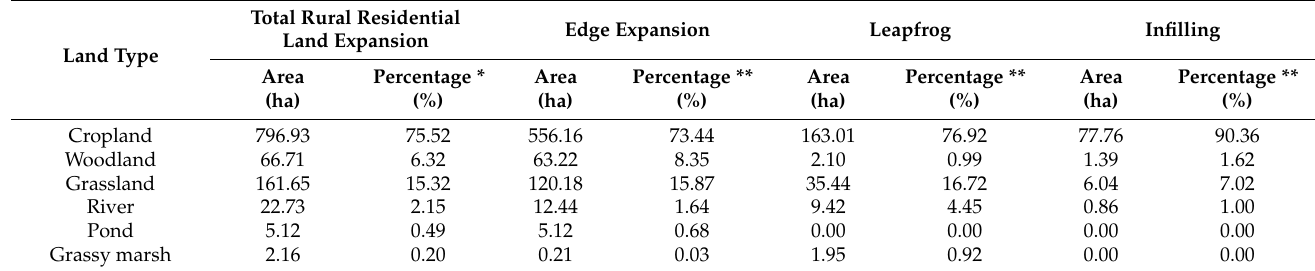
Table 2. Land-use transfer of rural residential land expansion between 1990 and 2015.